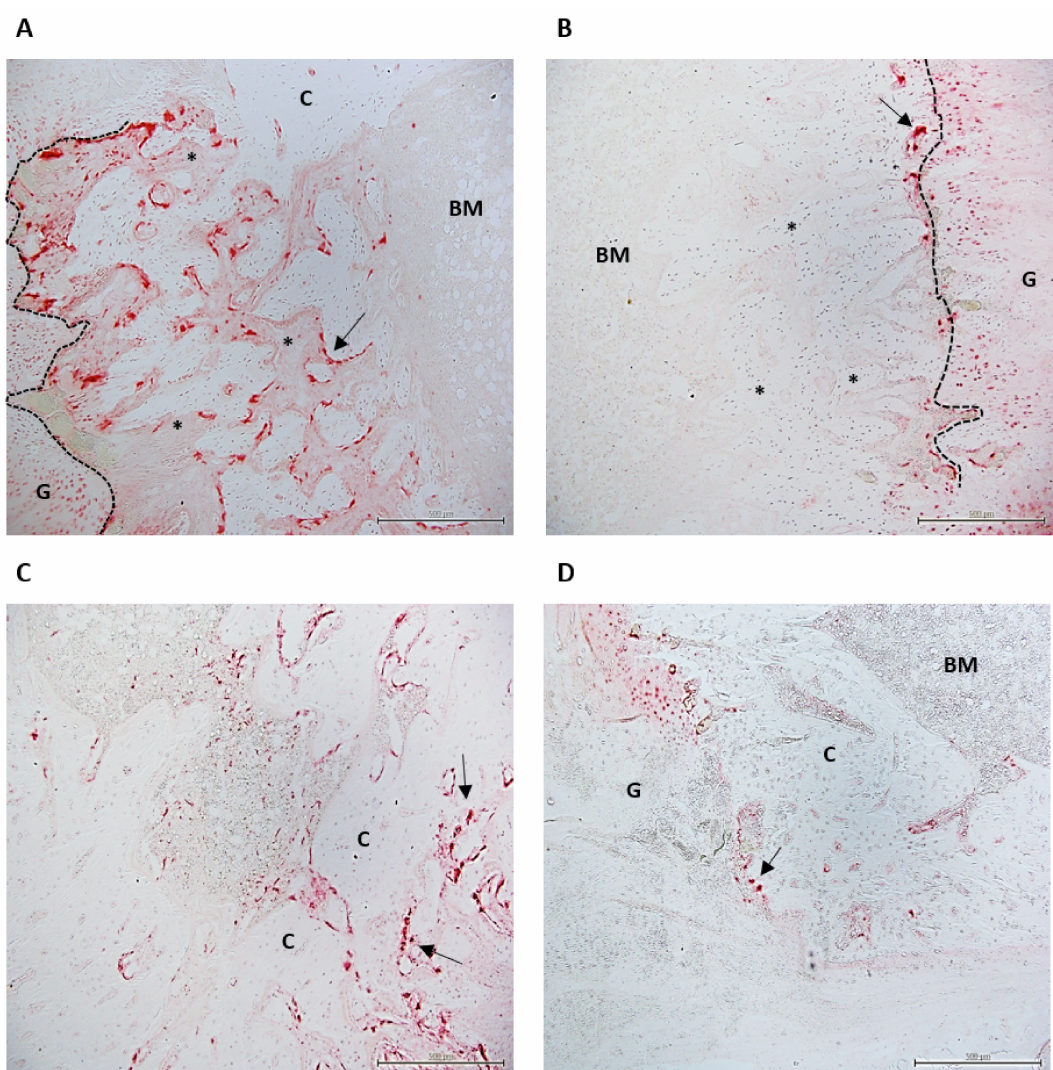
Figure 5. TRAP images of the distracted callus at low magnification ( × 10) 31 days ( A , B ) and 66 days ( C , D ) post-surgery in control ( A – C ) and G-CSF groups ( B – D ). At D31, in the control group, osteoclastic activity (arrow) is very high in the newly formed trabeculae (*) behind the mineralization front (dotted line) in the intraosteal area. In this area, in G-CSF animals, osteoclastic activity is restricted to the mineralization front (arrow). At D66, while osteoclastic activity is still significant in the extraosteal zone (arrow), this activity is minimal in this area in G-CSF animals (arrow). TRAP analysis was performed on 2 animals in each group at D31 and D66. C, cortical shaft; G, gap; BM, bone